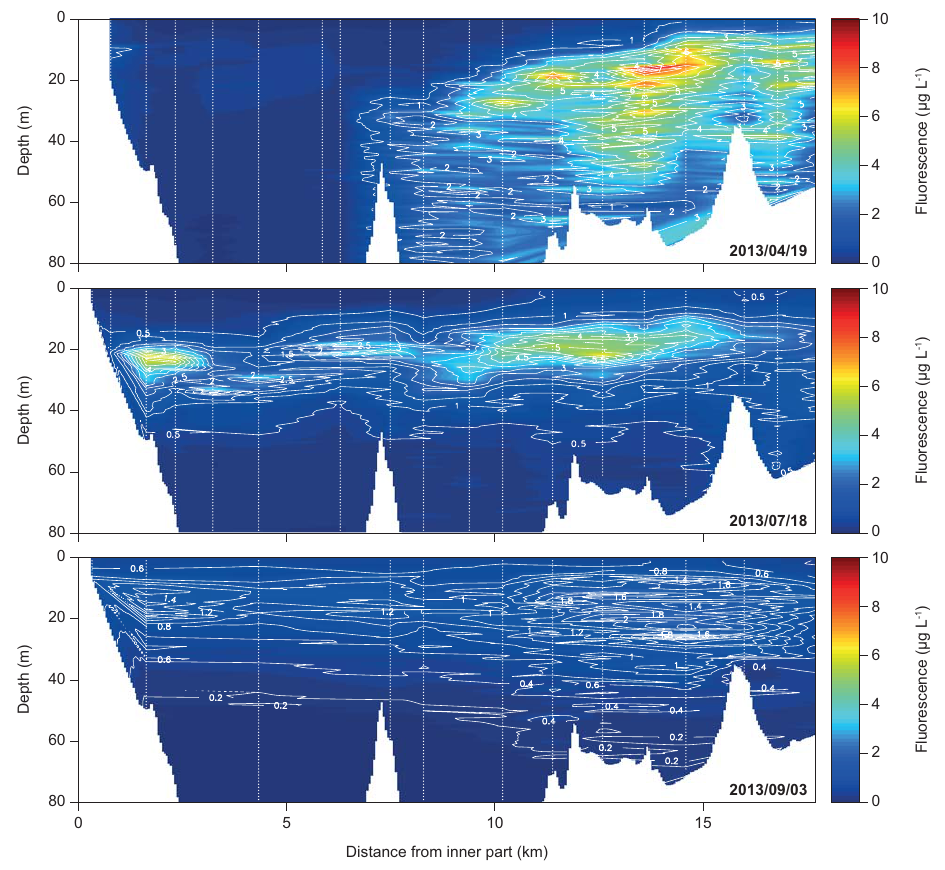
Figure A2. Fjord-scale variability in fluorescence in Kobbefjord, Nuuk, 19 April, 18 July and 3 September